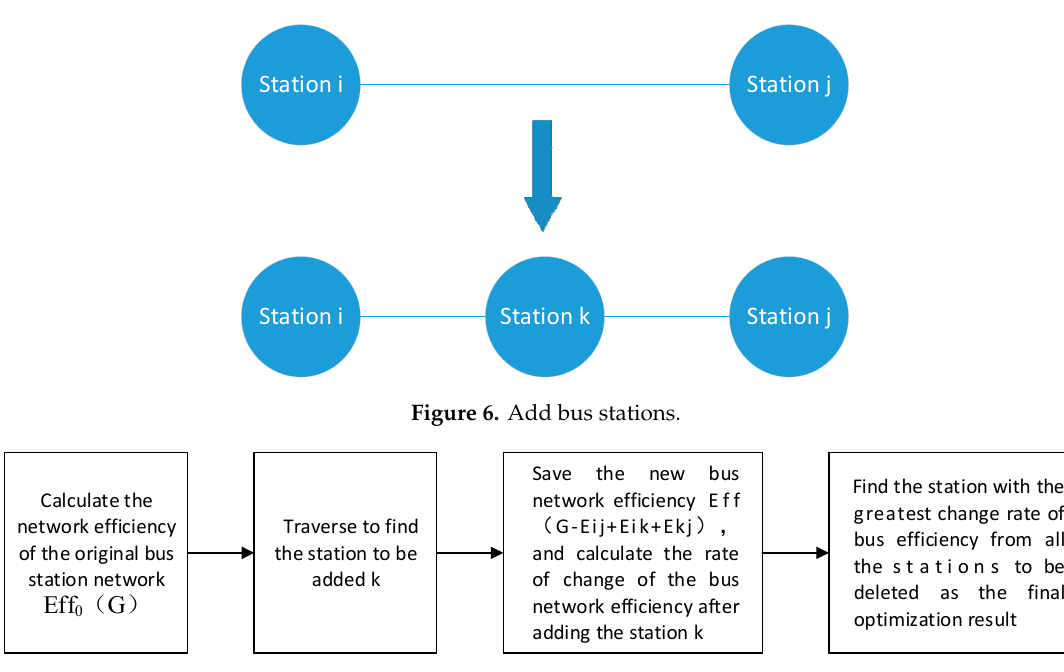
Figure 7. Add bus stops flow chart.